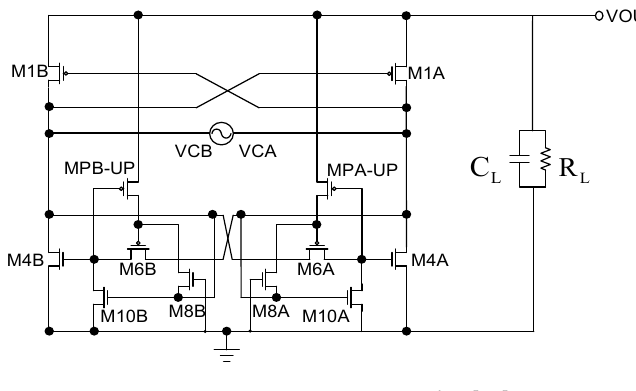
Figure 10. Comparative rectifier [10].